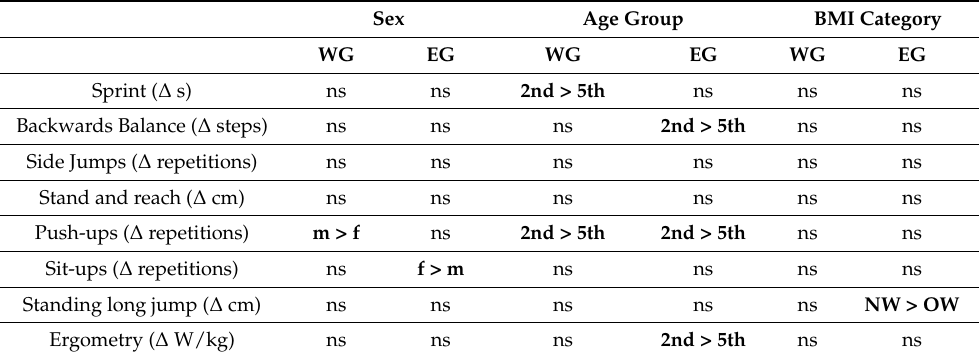
Table 3. Summary of interaction analyses on the effect of sex, age group, and BMI category on the change in motor